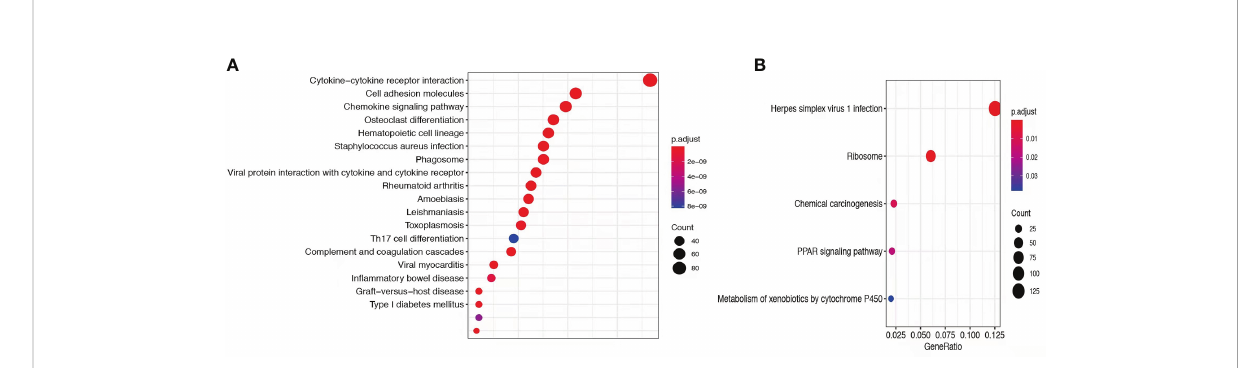
FIGURE 3 Comparative transcriptome sequencing of patient 1. (A) Up-regulated DEGs in P1 were enriched antifungal immune pathways. (B) Dot diagram showed the enriched pathways in P1. Color of nodes corresponding to signi fi cant levels. Size of nodes represented the number of genes in certain pathway.